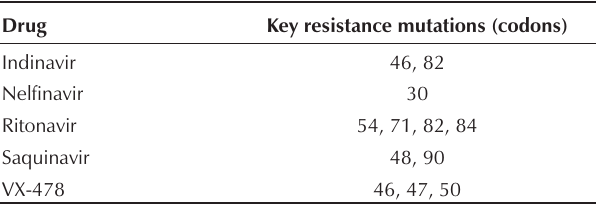
Different patterns of mutations for the five most studied protease inhibitors Drug Key resistance mutations